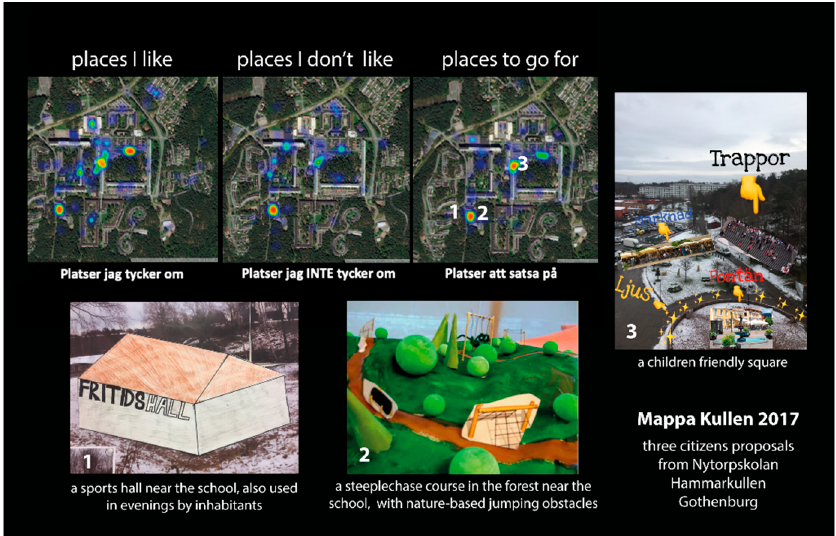
Figure 2. The results of pupil’s choice.